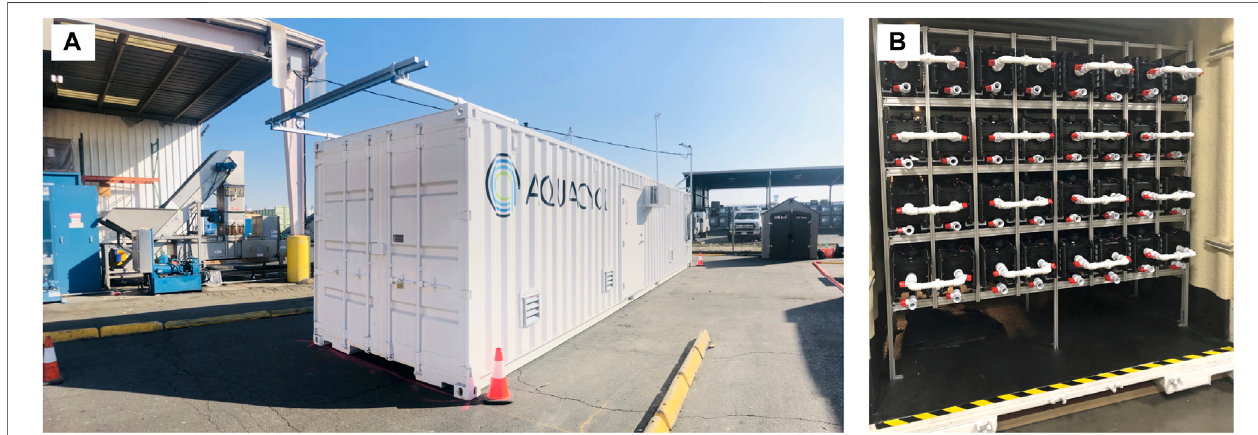
FIGURE9| 12-mC-BETTsysteminstalled atasodamanufacturer customersite. (A) OutsideviewofC-BETTand (B) BETT reactorsarrangementinsideC-BETT.